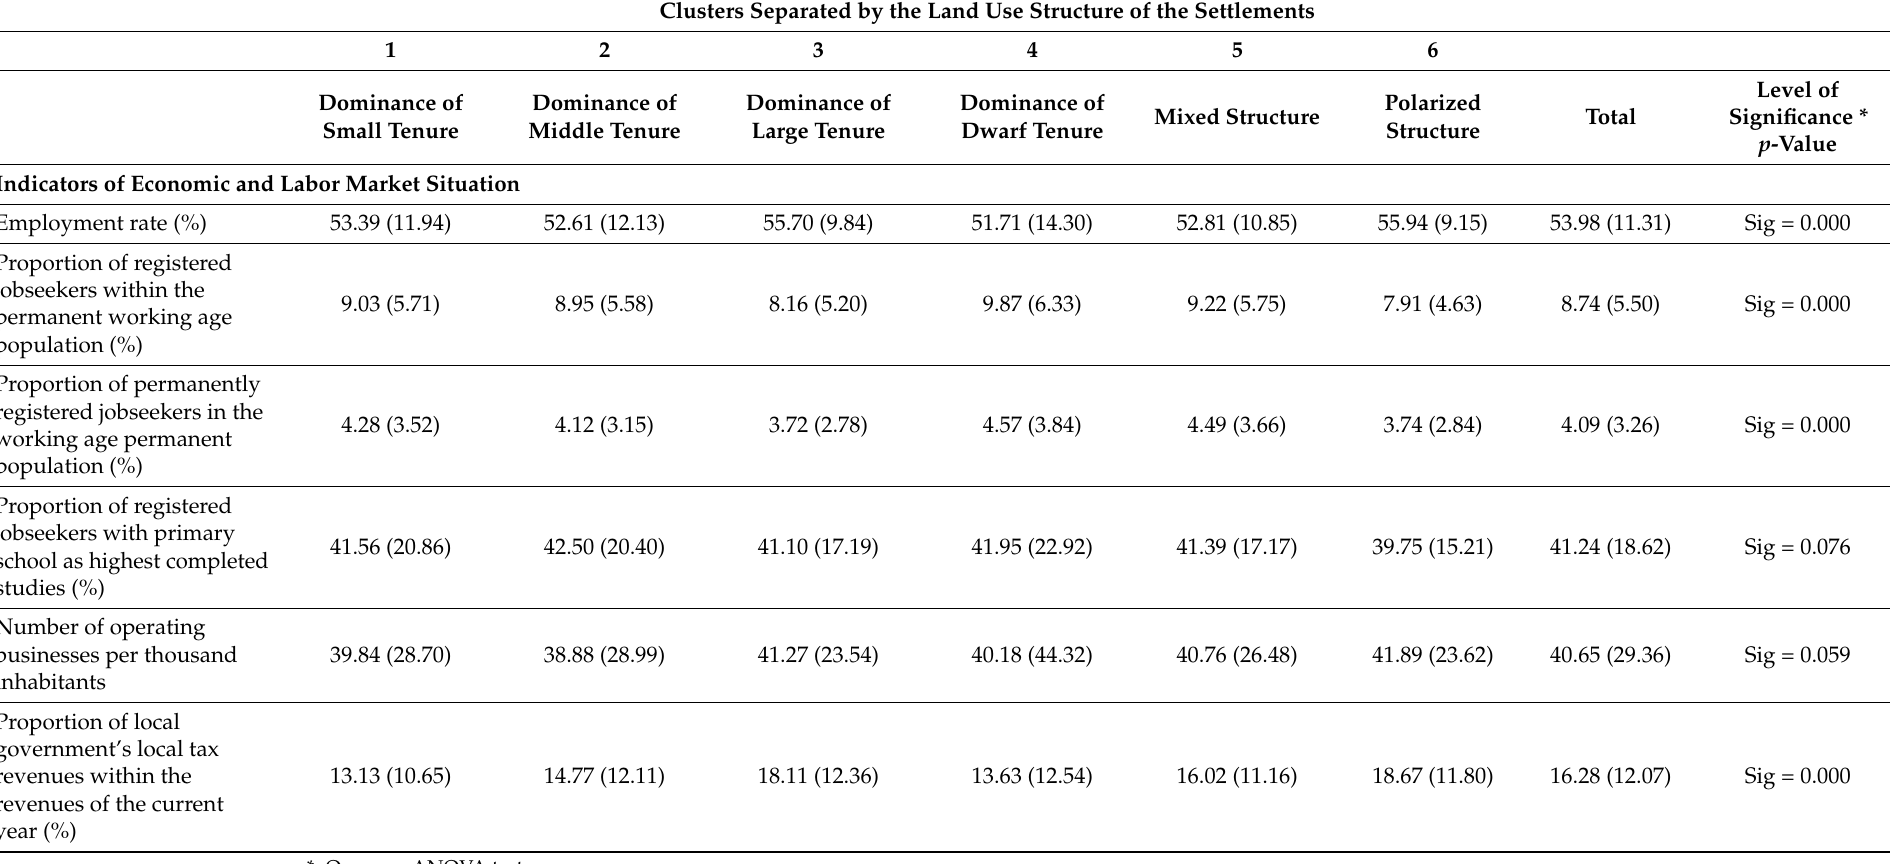
Table A4. Deviation of the six settlement clusters according to economic–labor market indicators, average values (standard deviations in brackets). Clusters Separated by the Land Use Structure of the